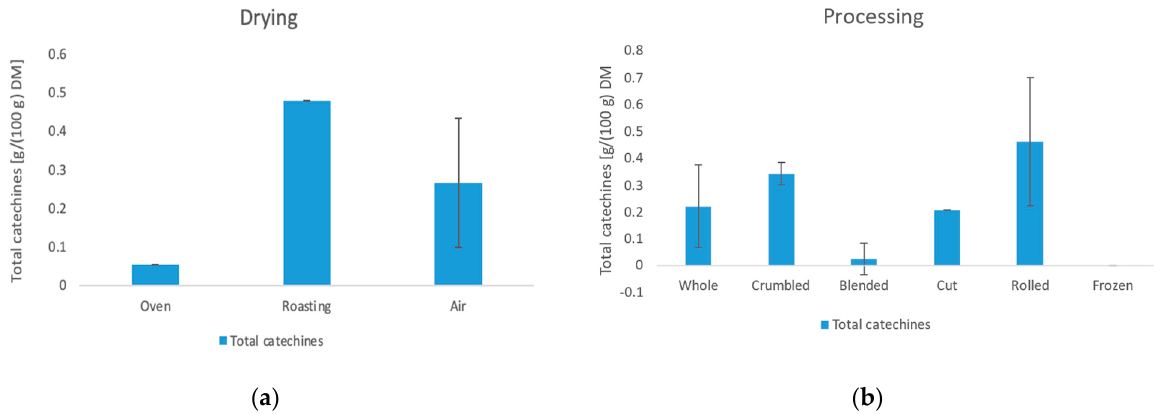
Figure 6. Influence of the drying method ( a ) and the processing method ( b ) on the total catechin content.